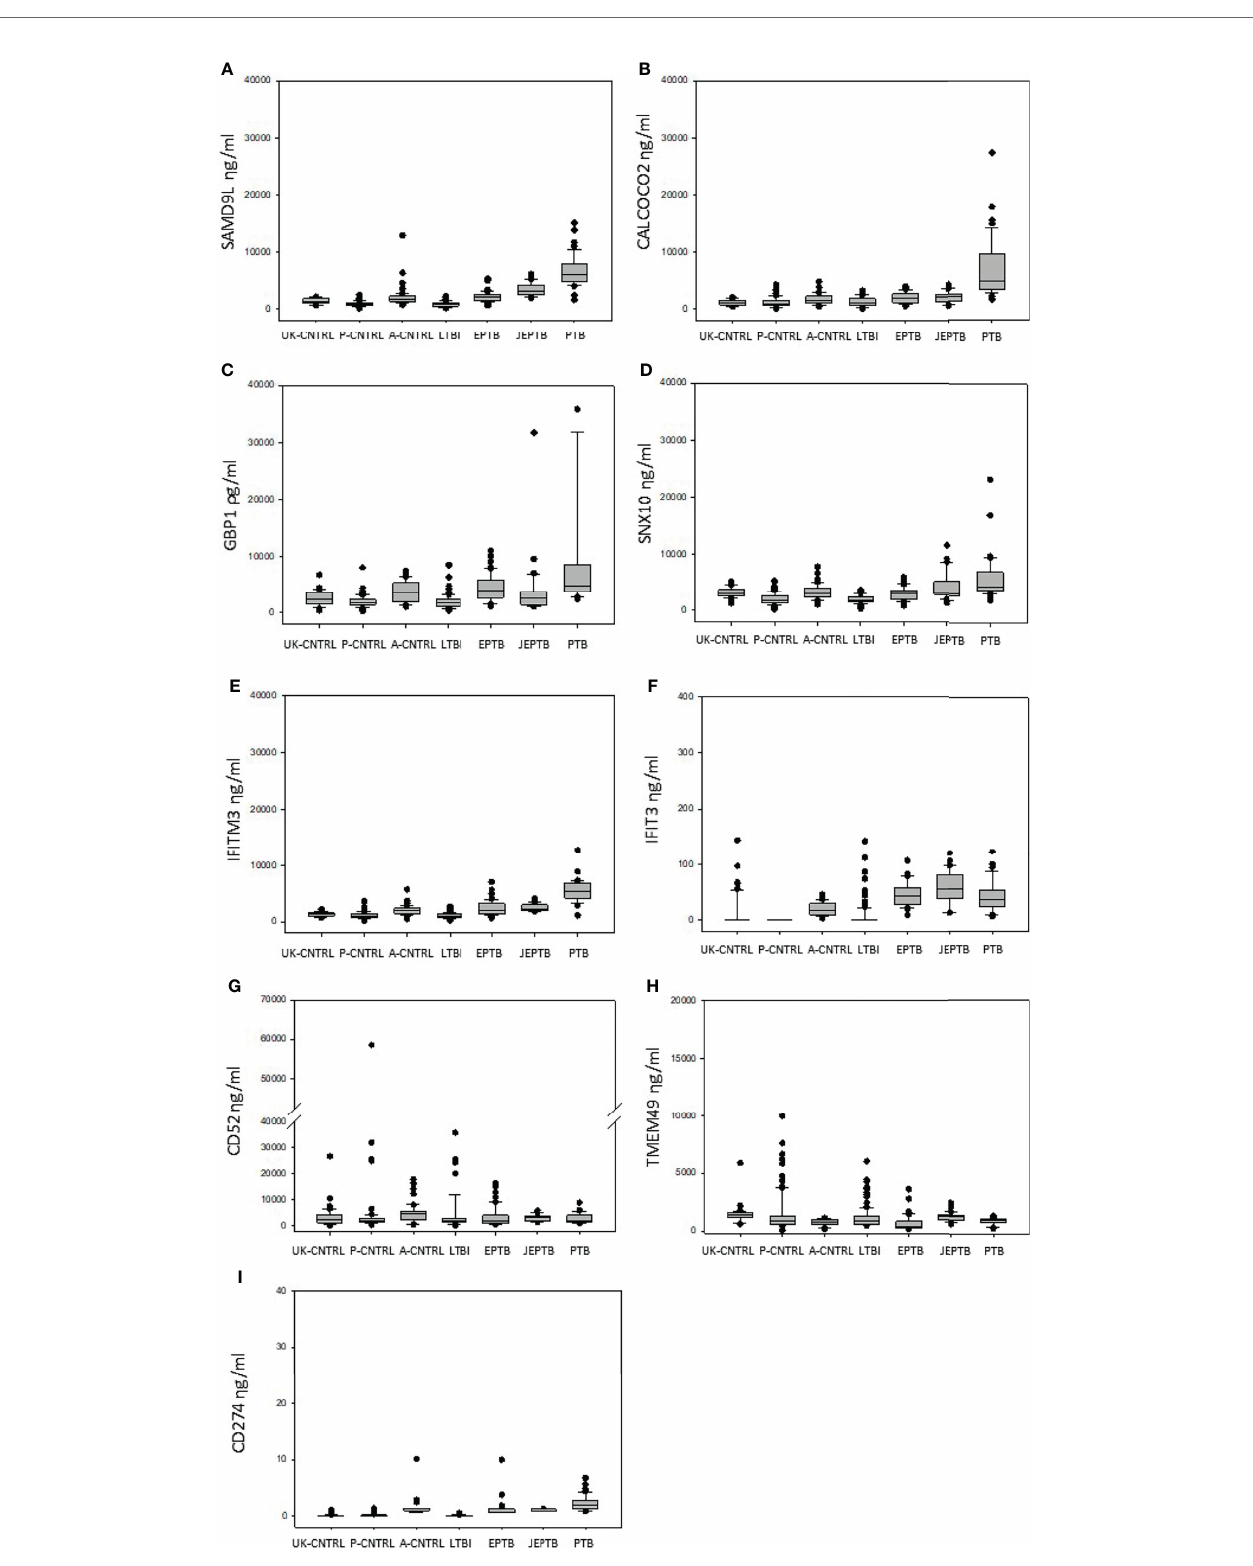
FIGURE 2 | Graphical boxplot depiction of biomarker expression across all control and patient groups (displaying median, minimum, maximum and interquartile expression range) (A) SAMD9L (B) CALCOCO2 (C) GBP1 (D) SNX10 (E) IFITM3 (F) IFIT3 (G) CD52 (H) TMEM49 (I)